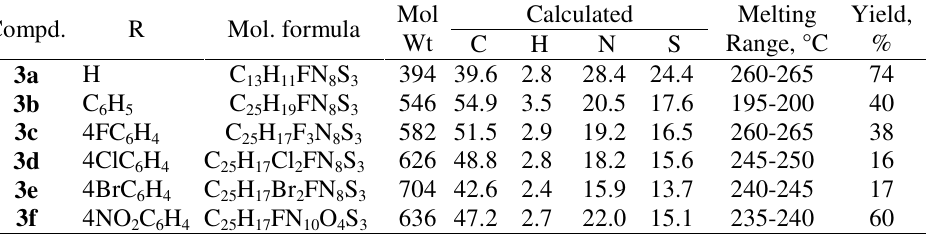
Table 2. Physical and analytical data of the synthesized compounds ( 3a - f )